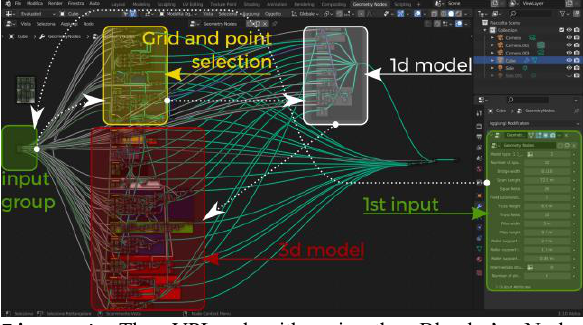
Figure 4 . The VPL algorithm in the Blender’s Nodes